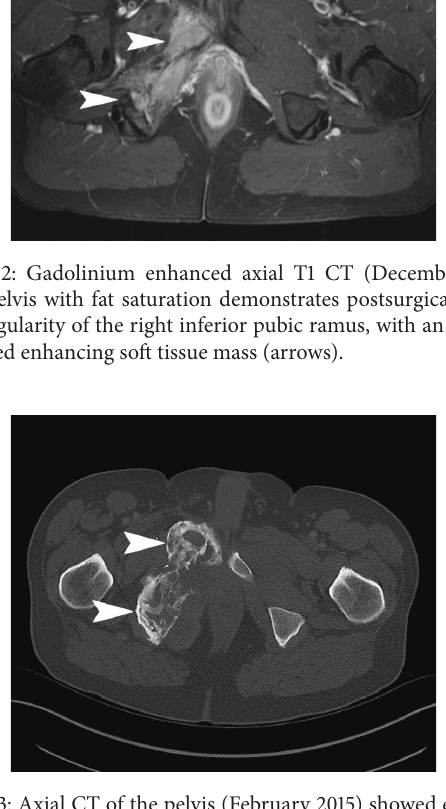
Figure 3: Axial CT of the pelvis (February 2015) showed extensive cortical irregularity and cystic spaces (arrows) of the right inferior pubic ramus (bone window